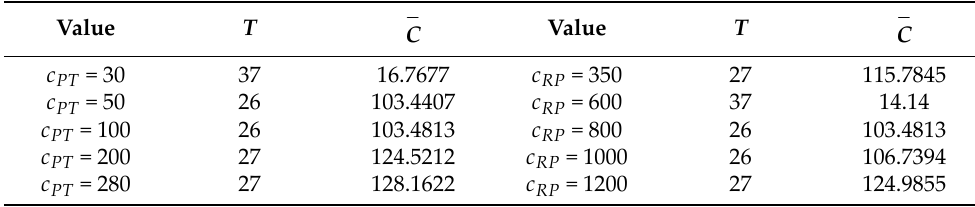
Table 5. Optimal results for different values of c PT and c RP